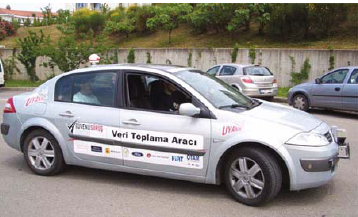
Figure 2. Instrumented car utilized in the collection of signals and images of the Uyanik